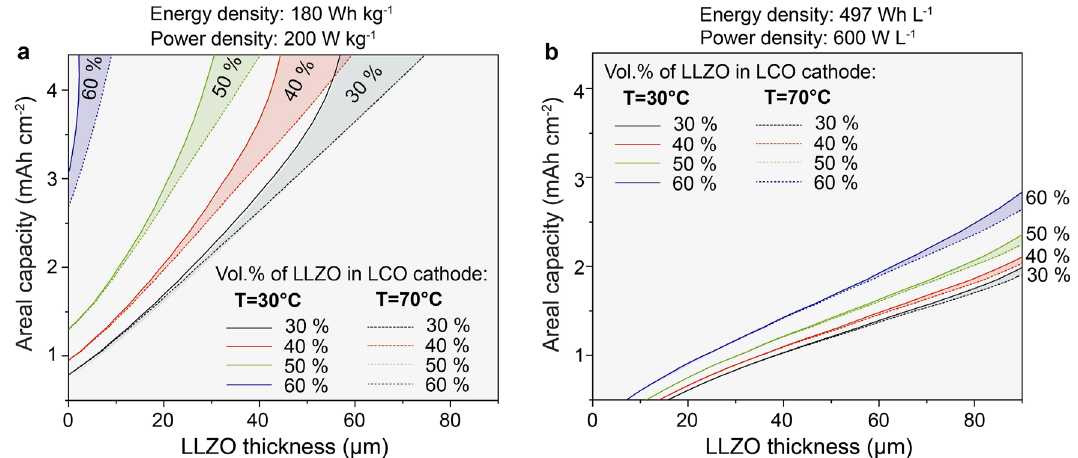
Figure 4. Gravimetric and volumetric break-even dependence of cathode areal capacity and LLZO thickness for Li/LLZO/LCO solid-state battery comprising LCO cathode with different volumetric content of LLZO. These dependencies were derived from simulated voltage profiles shown on Supplementary Figs. S2–S7, S8–S13, S14– S19, and S20–S25 and corresponding Ragone plots shown on Supplementary Figs. S27–S28, S31–S32, S33–S34, and S35–S36 (for 30, 40, 50, and 60 vol. % of LLZO in LCO). Complete sets of data of s imulated energy densities are shown on Fig. 3 (70 vol.% of LCO and 30 vol.% of LLZO), Supplementary Fig. S37 (60 vol.% of LCO and 40 vol.% of LLZO), Supplementary Fig. S38 (50 vol.% of LCO and 50 vol.% of LLZO), and Supplementary Fig. S39 (40 vol.% of LCO and 60 vol.% of LLZO).